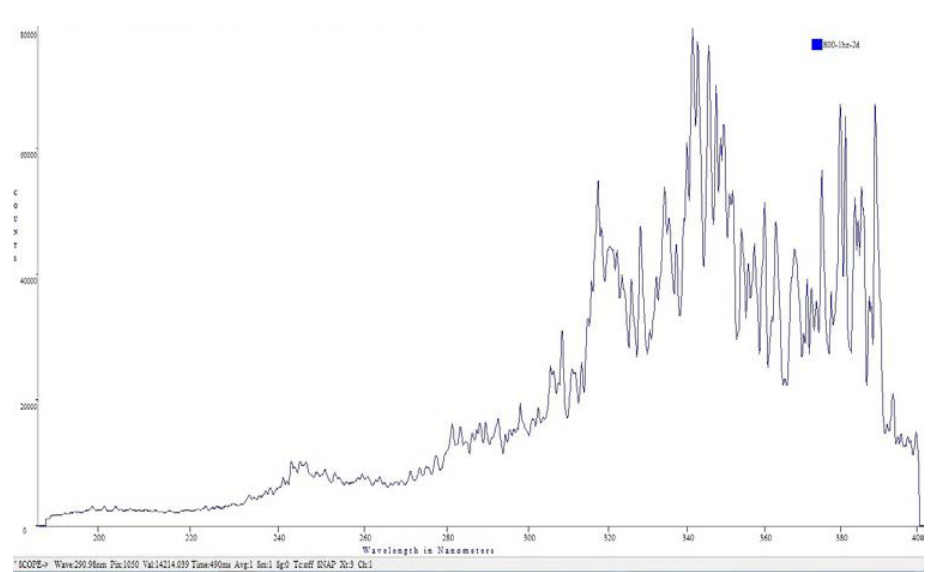
Fig.6: Emission spectra of laser energy 800 mJ with (1Hz) repetition